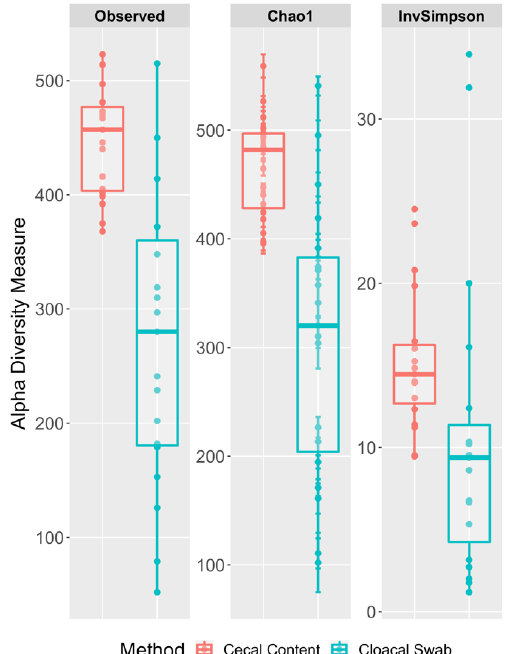
Figure 4. Boxplots of the observed, Chao1, and Inverse Simpson (InvSimp) α diversity indices for the comparison of cecal content and cloacal swab samples.